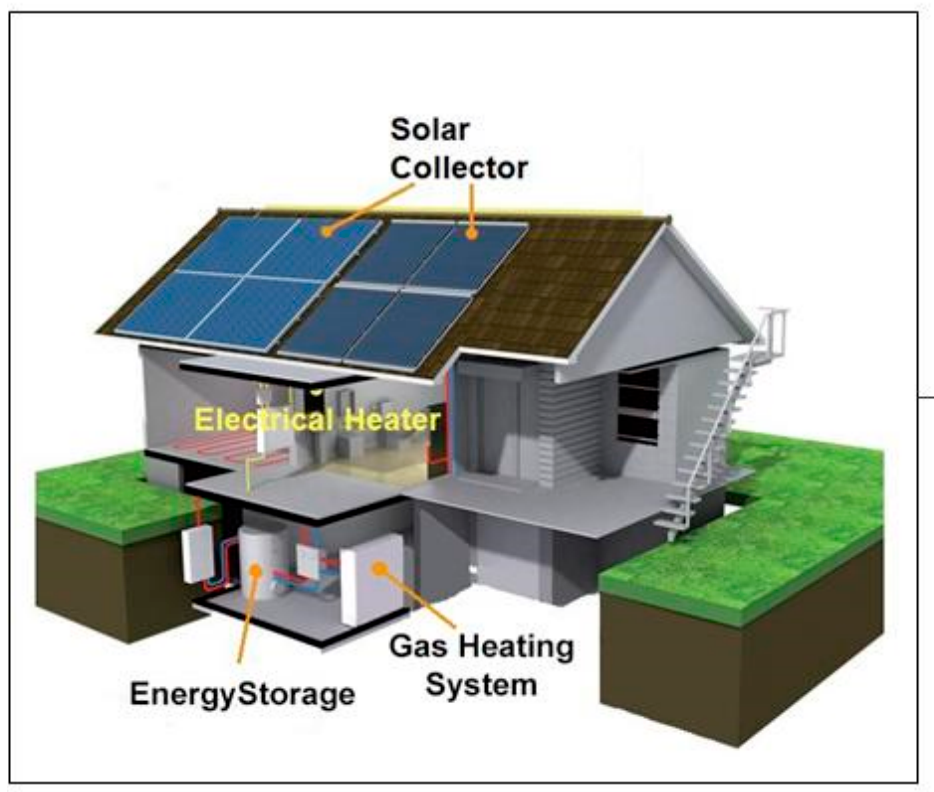
Figure 20. The schematic view of the controlled strategy used for energy management in buildings [168].